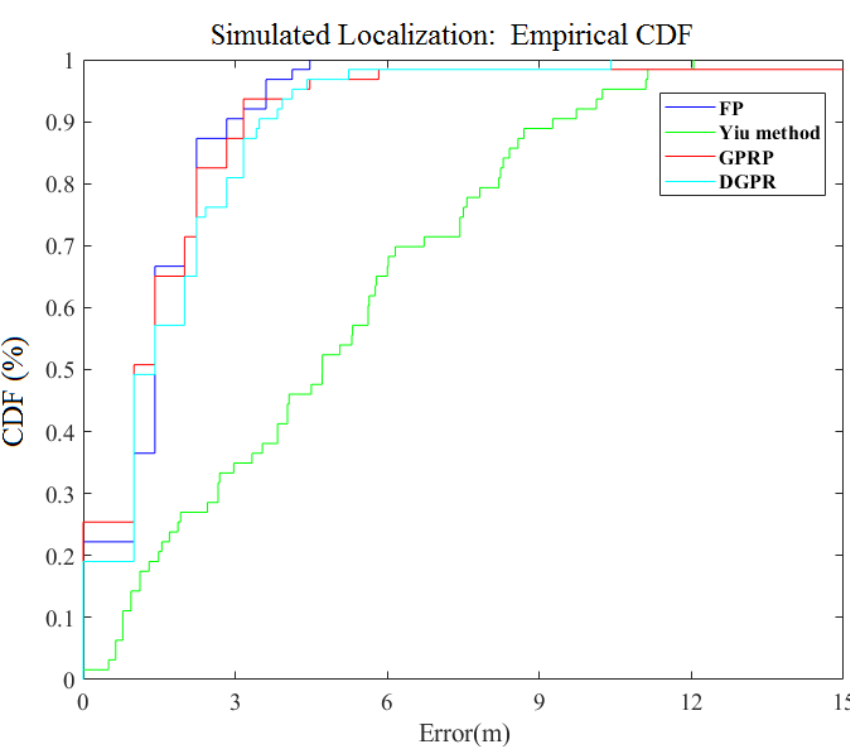
Figure 8. Comparison of CDF for simulated localization error of different algorithms.